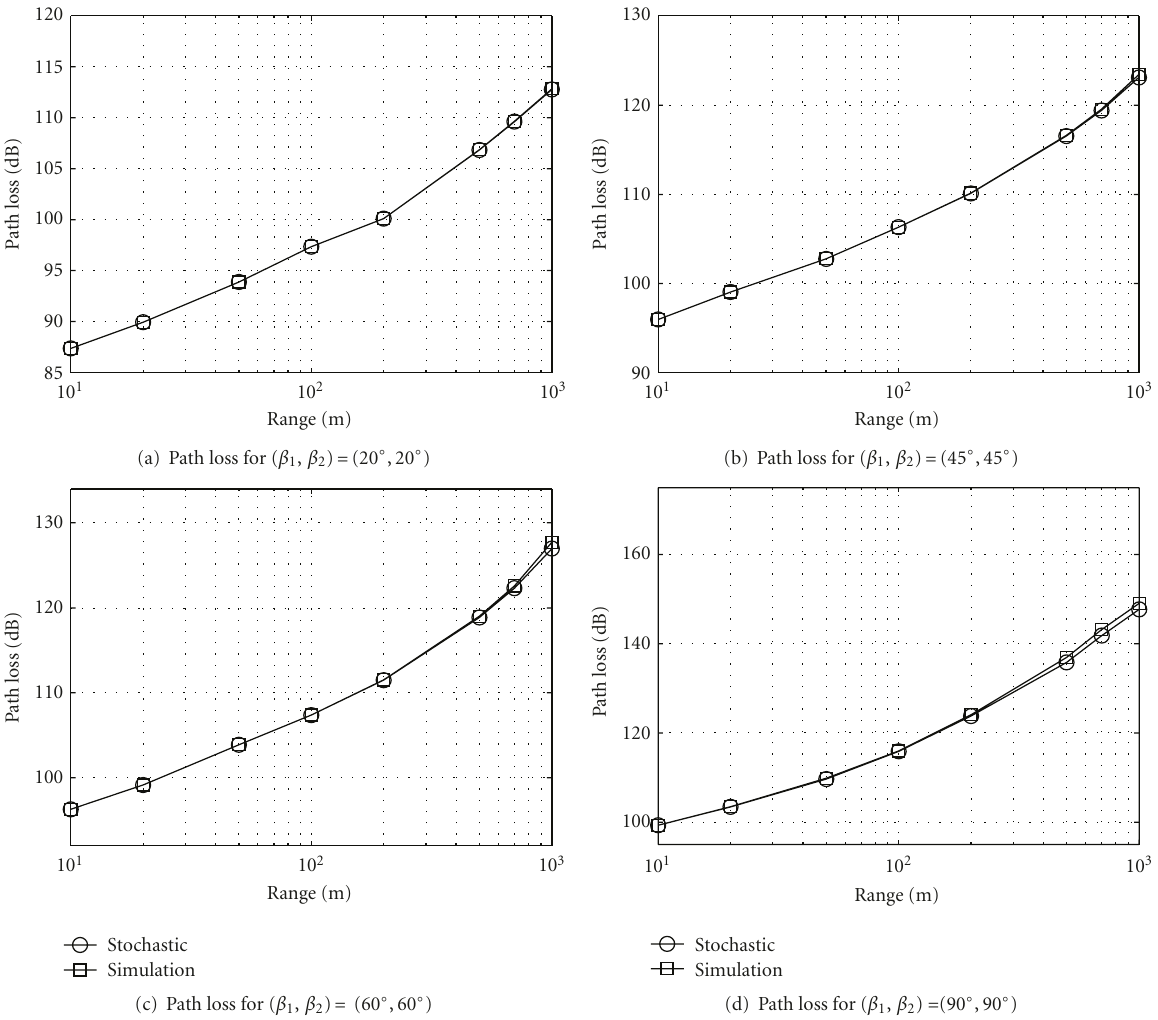
Figure 5: Comparison of the proposed stochastic model with the Monte Carlo simulation model